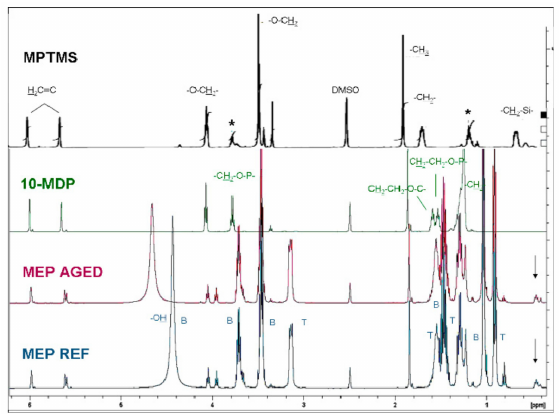
Figure 1. 1 H-NMR spectra of MEP, before and after aging, and of the controls (prehydrolysed MPTMS, 10-MDP). T and B peaks are assigned to TADF and butanediol, respectively. Arrows show the